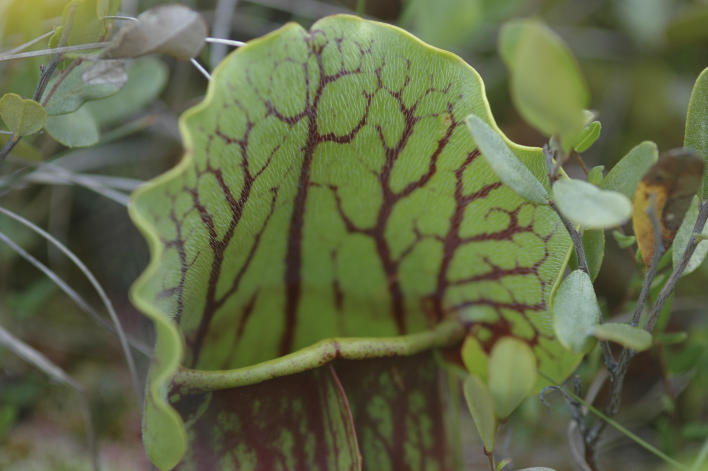

Sarracenia purpurea. (Photo: Nicholas J. Gotelli)